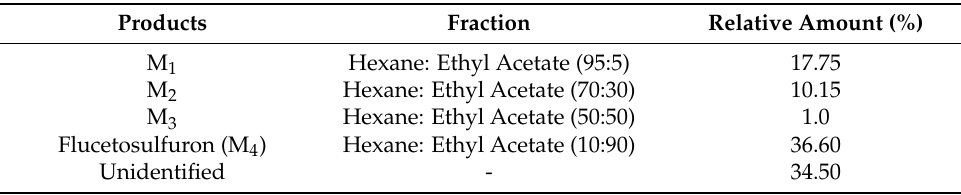
Table 5. Extraction scheme and the relative number of